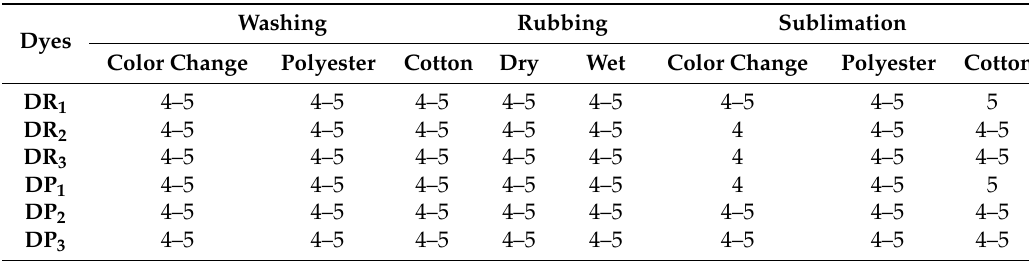
Table 1. Color fastness properties of the silicon-containing reactive disperse dyes on rubbers. Washing Rubbing Sublimation Dyes Color